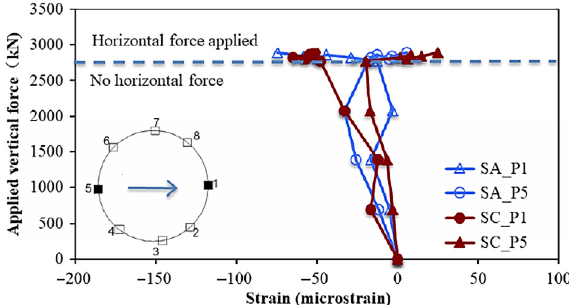
Figure 8. Normal stress versus applied vertical force for Type B in Stage 1